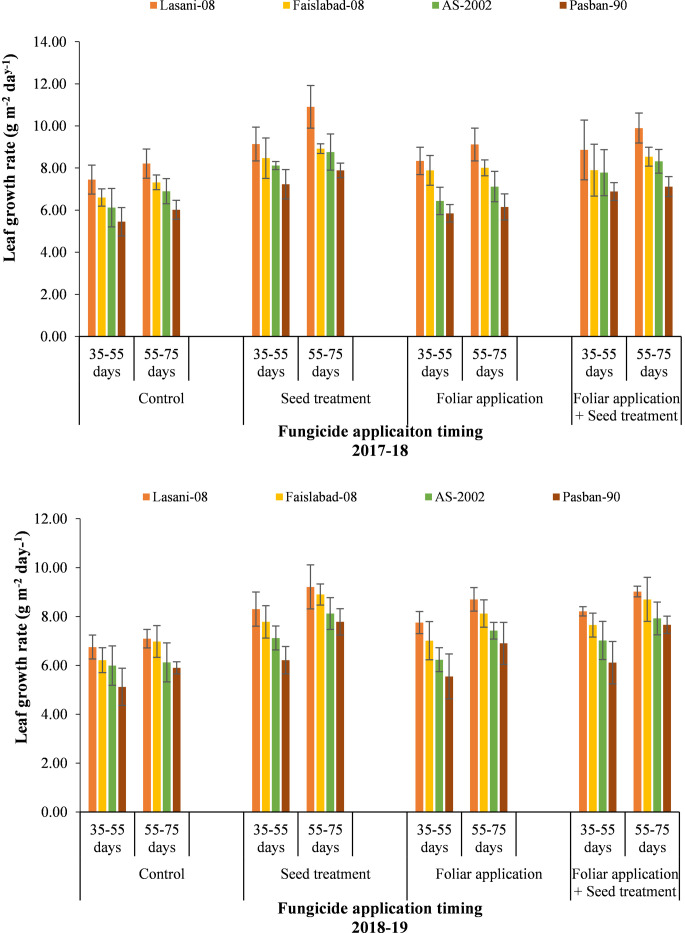
The influence of different fungicide application timings on leaf growth rate of wheat cultivars with varying tolerance to Karnal bunt disease.